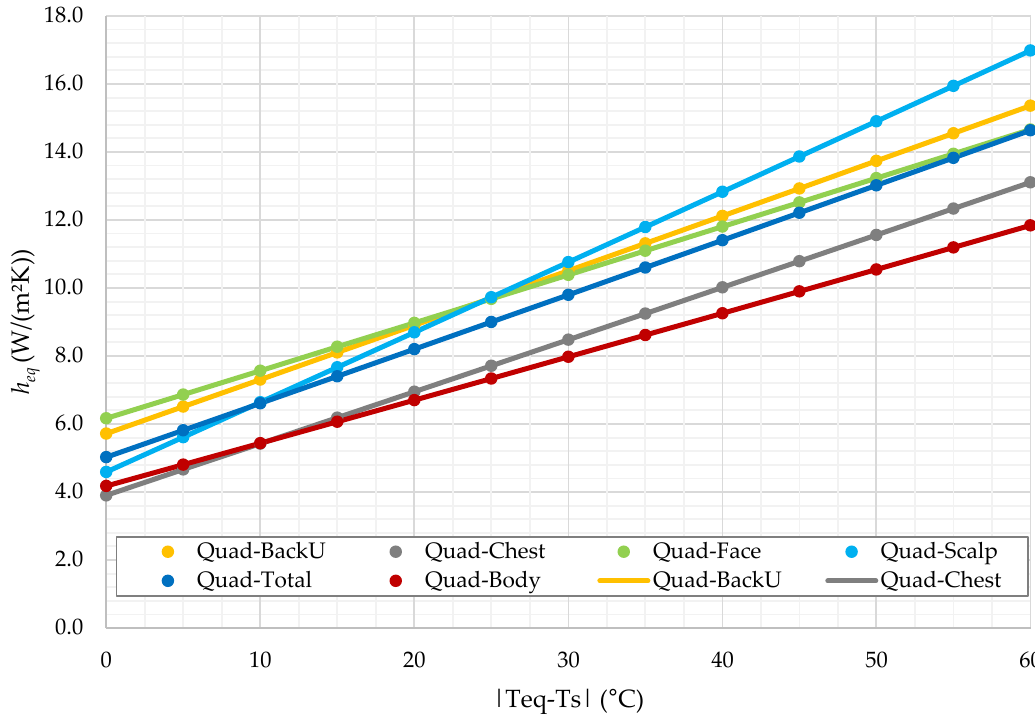
Figure 7. h eq quadratic relation for body segments group 2. A coefficient matrix K contains the parameters for the quadratic regression for each Table 3. Body segments assignment by index, letter, and name. body segment via the index j and is constructed as